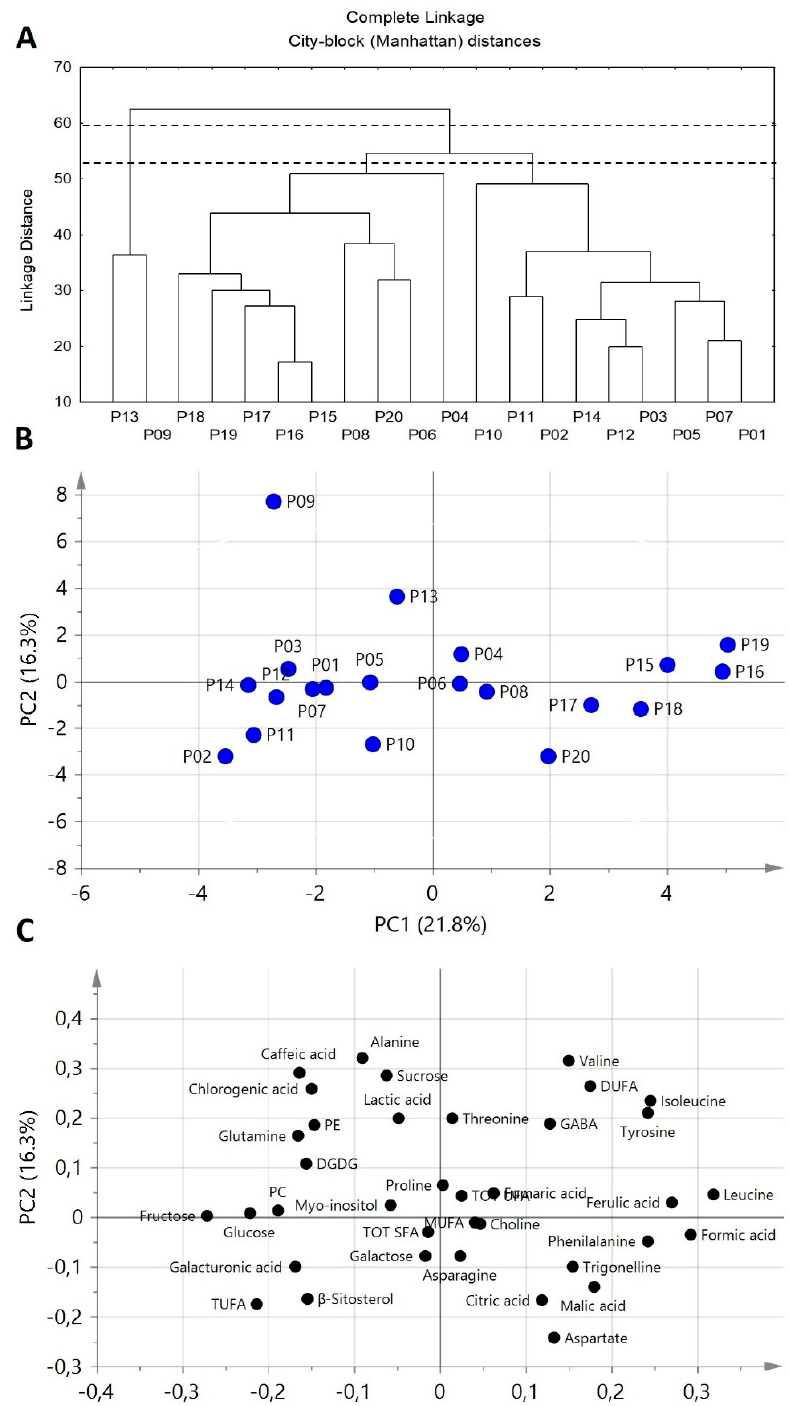
Figure 5. TCA (Tree Clustering Analysis) and PCA (Principal Component Analysis) applied to NMR and HPLC data relative to twenty potato cultivars (see Material and Methods section). Dendrogram (TCA) cut on two levels ( A ). PCA maps of potato sample scores ( B ) and loadings ( C ). PC1 and PC2 represent 21.8% and 16.3% of the total variance, respectively.